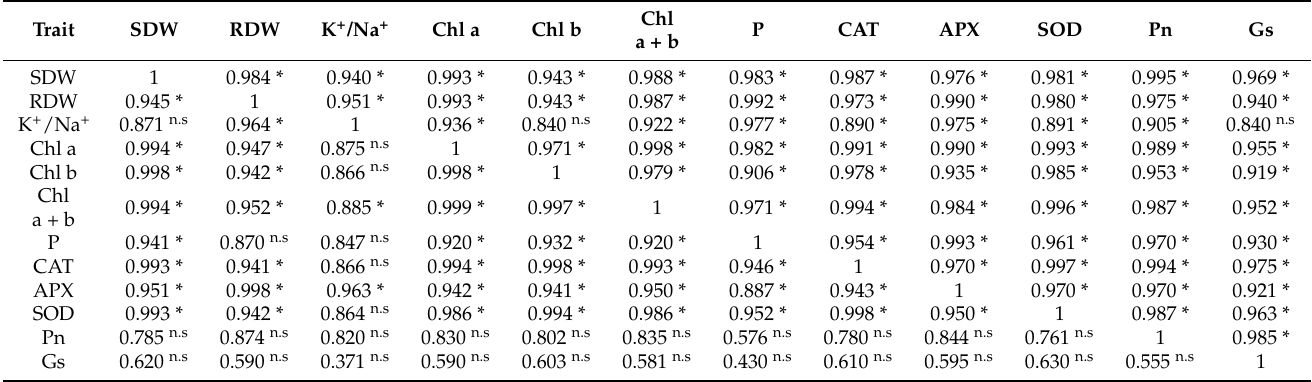
Table 2. Correlation coefficients between treats for different parameters of sorghum under non-saline) the bottom lines of the table (and saline conditions (the top lines of the table) in all foliar-applied SA concentrations (for each parameter n =